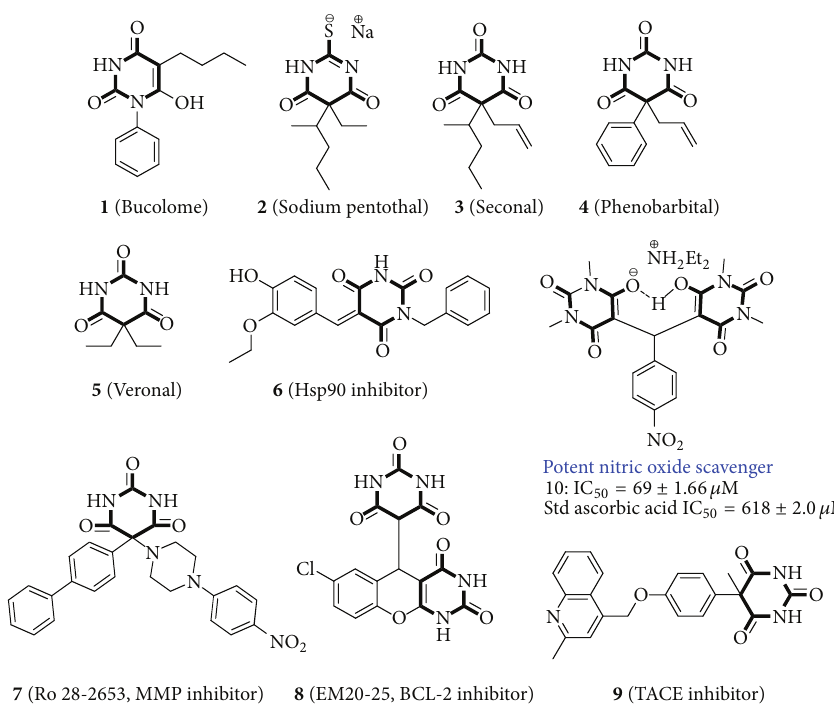
Figure 1: Structure of biologically active barbituric acid